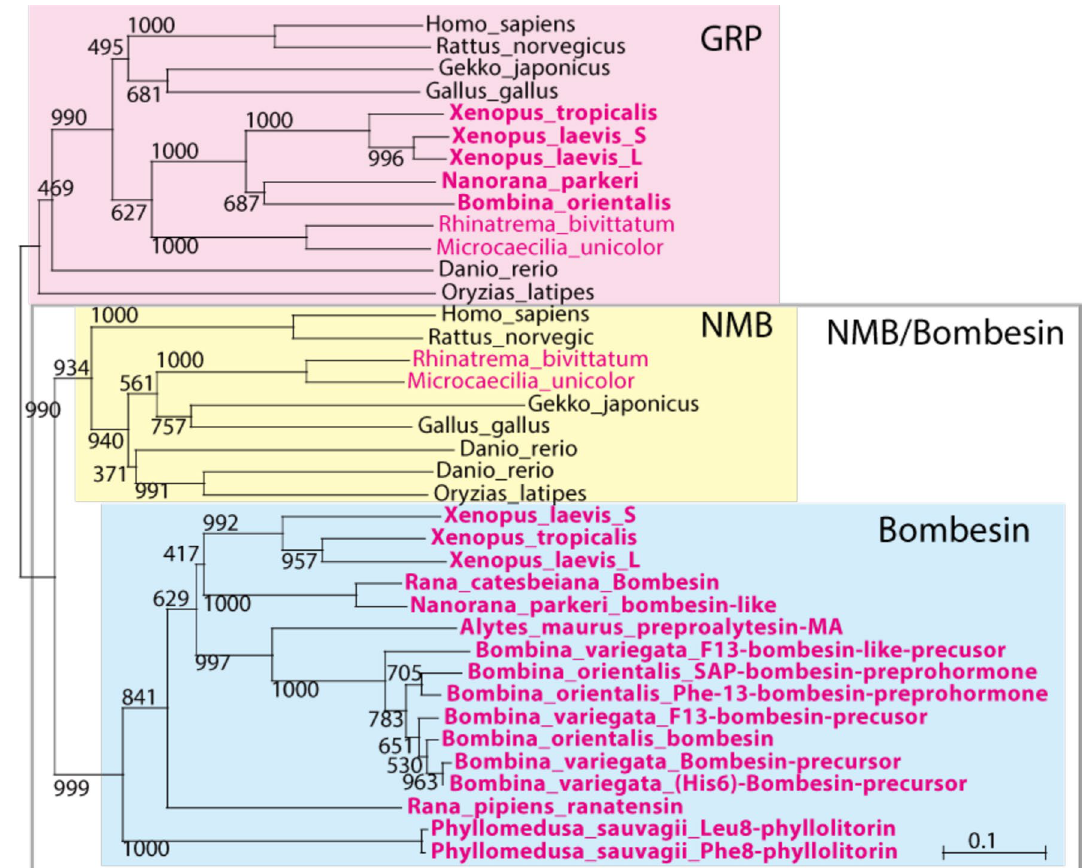
Figure 1. Molecular phylogeny of precursors of gastrin-releasing peptide (GRP)/neuromedin B (NMB)/ bombesin family peptides. GRP/NMB/bombesin family peptides are classified into a GRP clade (pink box) and an NMB/bombesin clade (gray frame). While GRP was found in all the animals examined, genes included in NMB clade were not found in frogs (yellow box). All bombesin-like peptides in frogs appeared to form a single bombesin clade (blue box). Species name in magenta: amphibians; bold: frogs. IDs for the protein sequences used in this analysis are shown in Supplementary Table